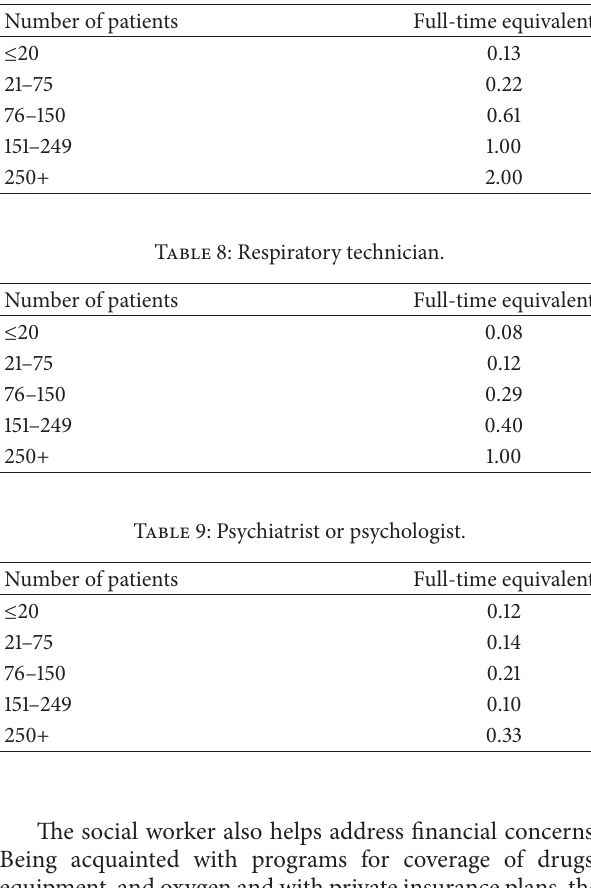
Table 7: CF clinic secretary/administrator.